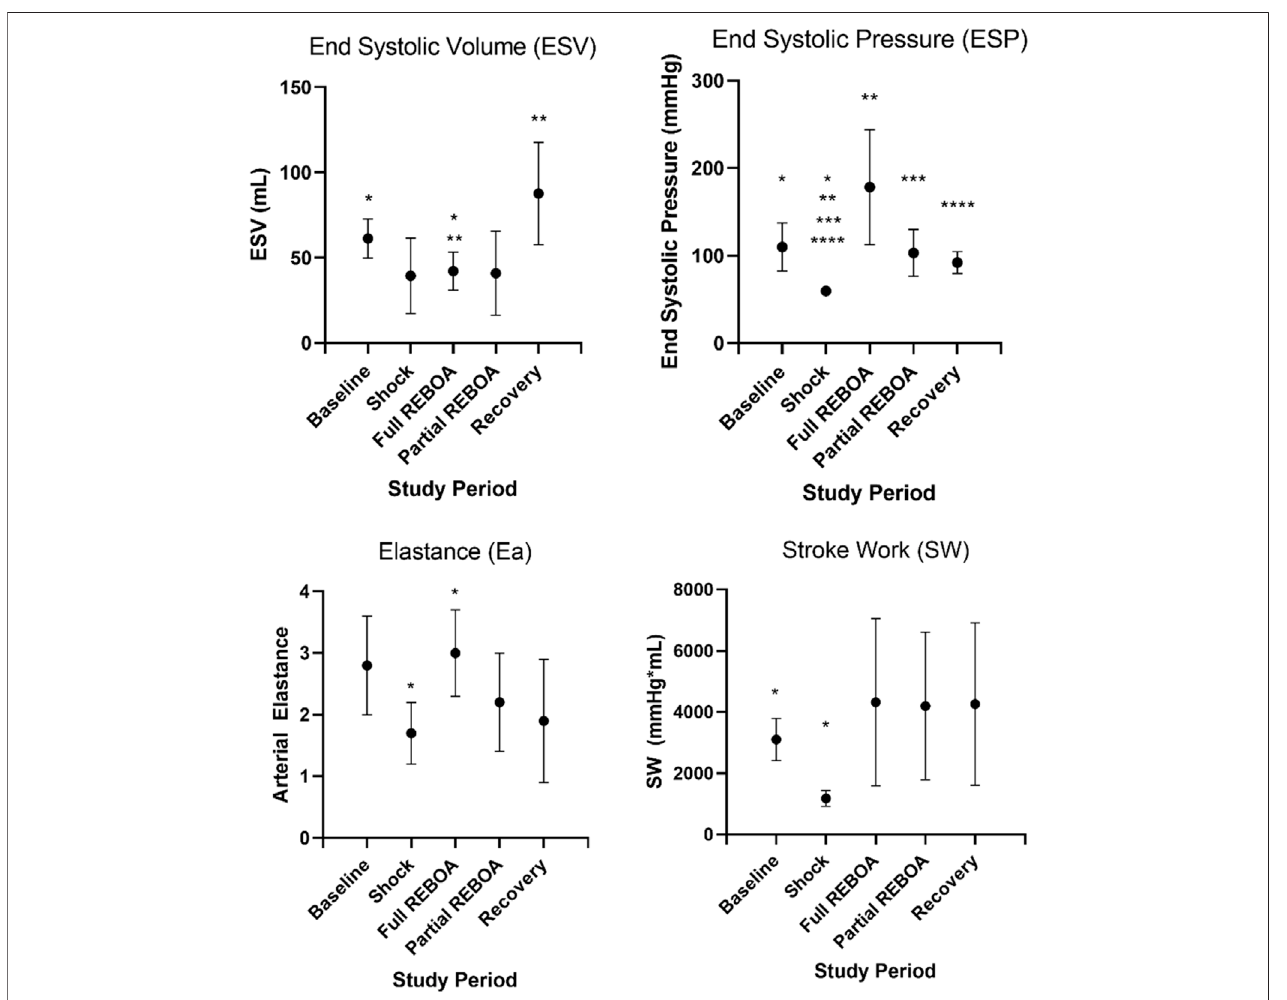
FIGURE 3 | Select left ventricular functional parameters from Supplementary Table S1A . Here SW, Ea, ESV and ESP are plotted against study period. Asterisks denote statistical signi fi cance between parameters across study periods, p values provided in Supplementary Table S1B .